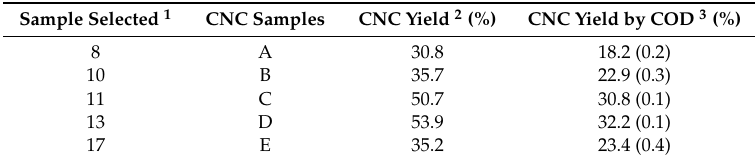
Table 3. CNCs yield of the five samples